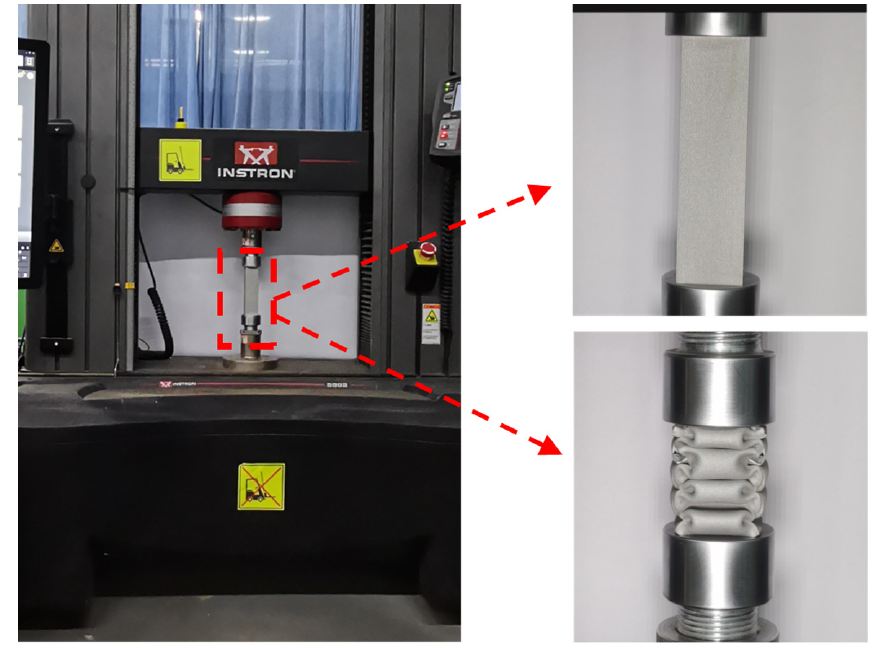
Figure 6. Quasi-static compression experimental system. Figure 6. Quasi‑static compression experimental